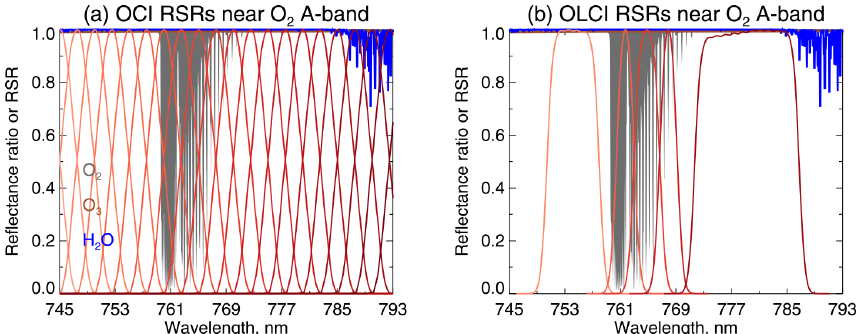
Figure 1. Relative spectral response functions (RSRs) for (a) OCI, based on current expectations, and (b) Sentinel 3a OLCI, based on pre- launch measurements, in the region of the O 2 A-band. RSRs are shown in red, with different tones indicating different channels. Absorption by various species (see text) is shown in dark grey shading for O 2 , brown lines for O 3 (which has very weak absorption), and blue lines for H 2